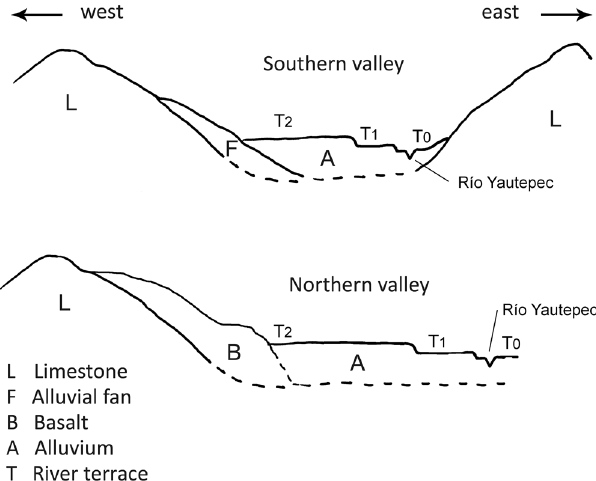
Figure 2: Cross - sections showing geological formations in the north and south parts of the Yautepec